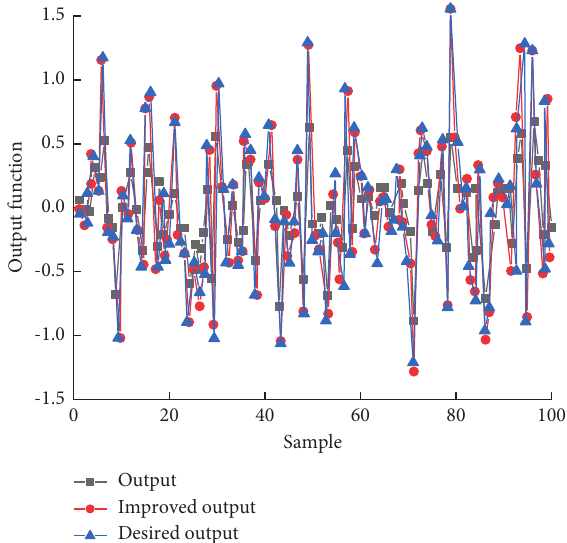
Figure 9: Outputs the comparison values.